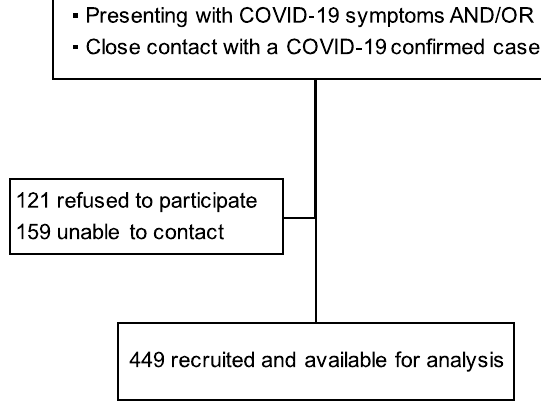
Figure 1. Flow diagram for inclusion in this